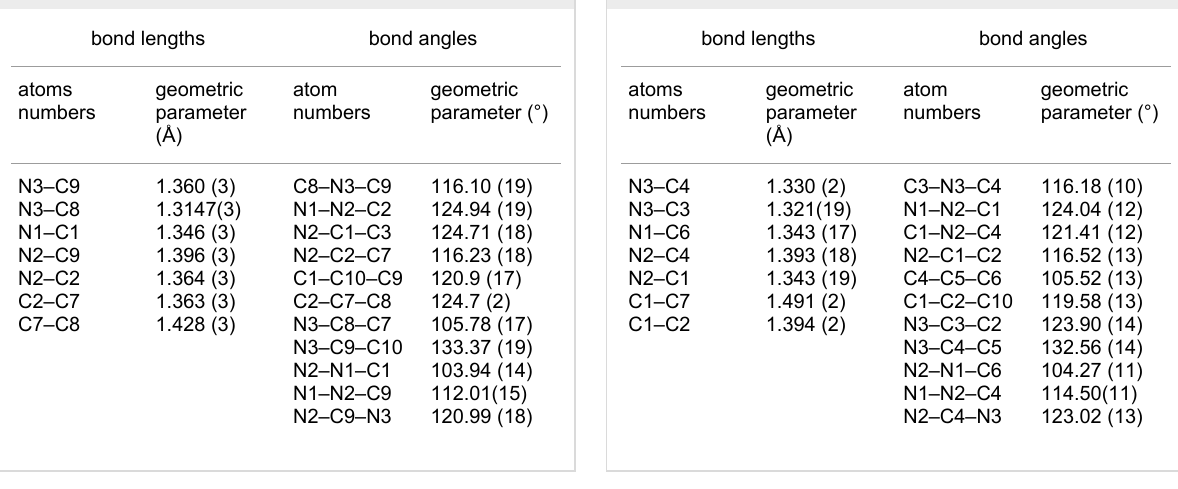
went cyclization to give 6g (Scheme 1). Moreover, the struc- ture of compounds 6b – g was unequivocally established by single-crystal X-ray diffraction of compounds 6e , g (Figure 3, Figure 4 and Table 3, Table 4) [27,28].